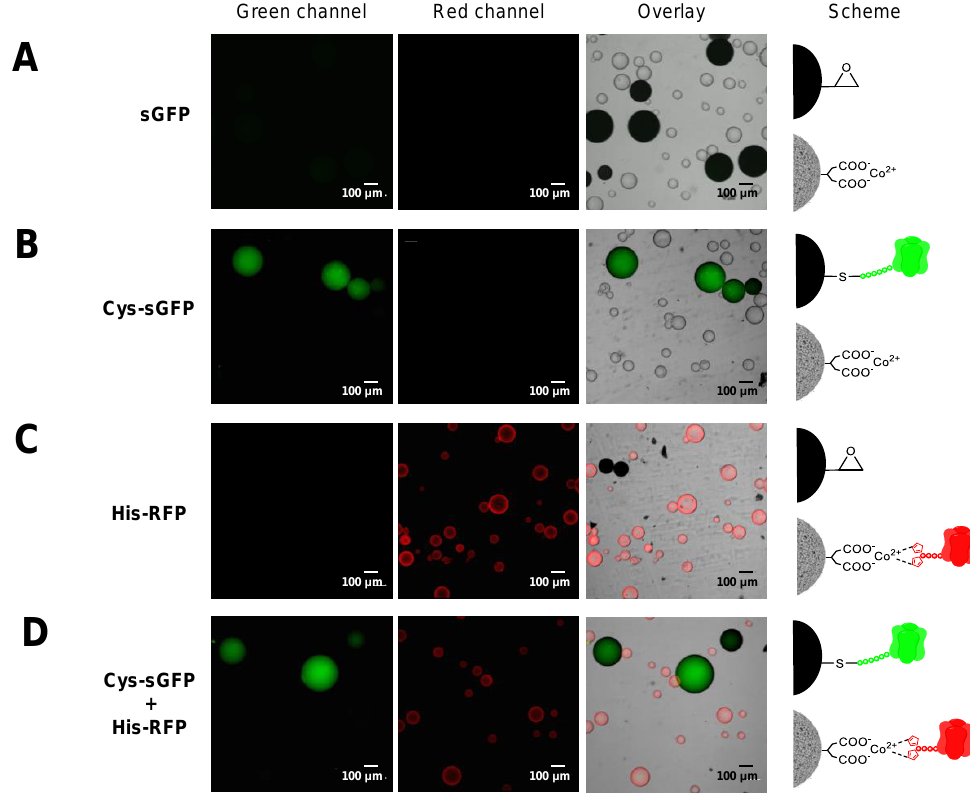
Figure 4. CLSM imaging of the tag-driven selective immobilization of FPs on Purolite ® and TALON ® . ( A ) Untagged sGFP was incubated with both Purolite ® and TALON ® , but no immobilization was detected. ( B ) Cys-sGFP was incubated with both Purolite ® and TALON ® , but only immobilized on Purolite ® by irreversible covalent bonds. ( C ) His-RFP was incubated with both Purolite ® and TALON ® , but only immobilized on TALON ® by metal coordination bonds. ( D ) Cys-sGFP and His-RFP were incubated with both Purolite ® and TALON ® . Cys-sGFP and His-RFP were selectively immobilized on Purolite ® and TALON ® , respectively. From left to right: green channel ( λ ex : 488 nm, λ em : filter LP505 nm), red channel (( λ ex : 561 nm, λ em : filter LP565 nm), overlay of fluorescence and brightfield signals, and the scheme of the protein